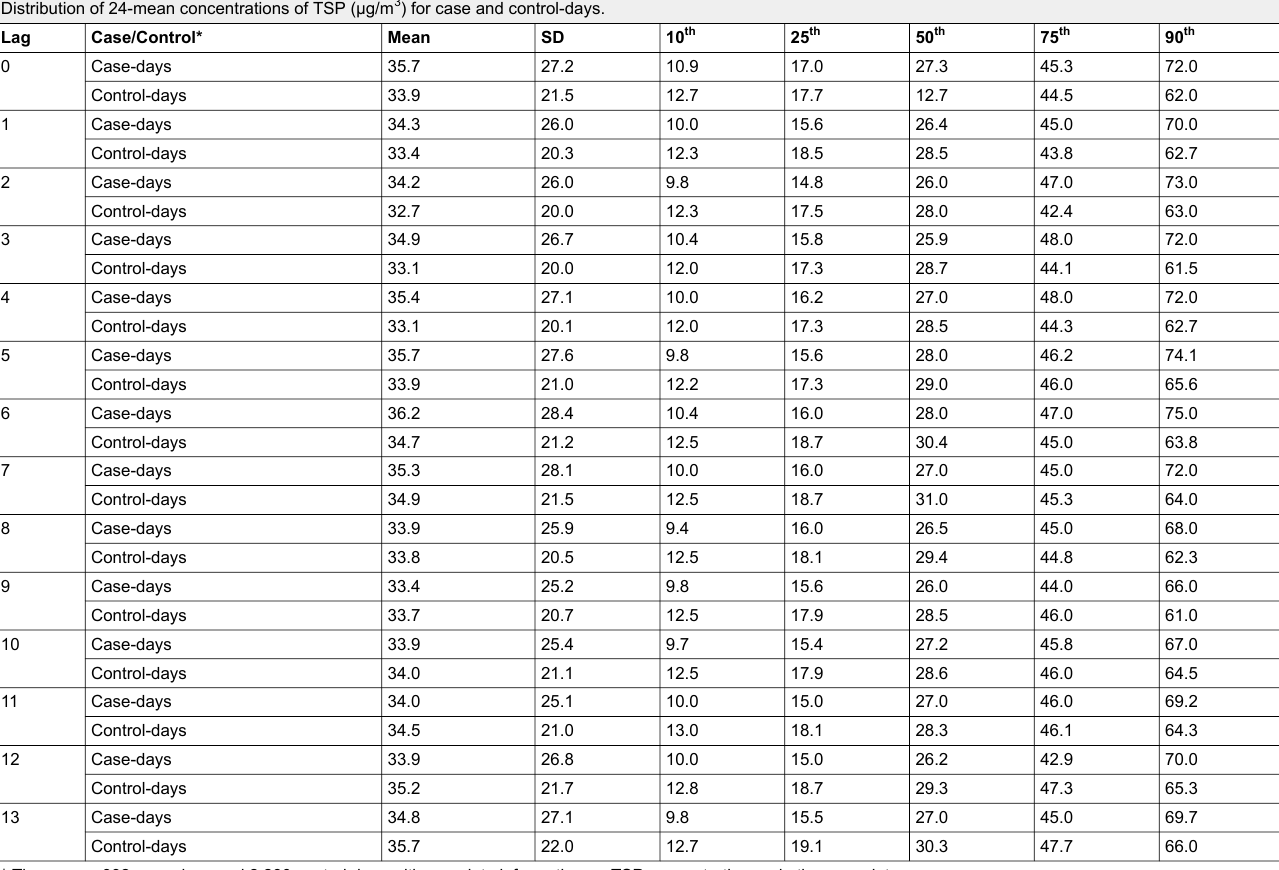
Supplementary file: Table 4 Distribution of 24-mean concentrations of TSP (µg/m 3 ) for case and control-days.